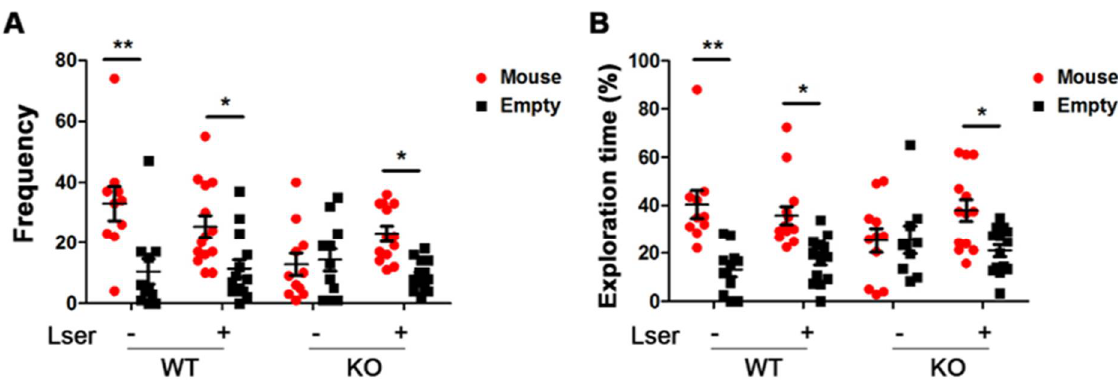
Figure 3. Oral administration of L-serine attenuated autistic-like behavior in GHRH-KO mice. Three- chamber sociability was conducted with GHRH-KO mice and age-matched wild type controls upon L-serine intervention for 12 weeks. ( A ) Frequency of exploring in the empty cage and strange mouse cage during the entire sociability trail time. ( B ) Percentage of exploration time spent in the empty cage and strange mouse cage during the entire sociability trail time. n = 11–14 mice per group. Data represent means ± SEM. * p < 0.05, ** p < 0.01.